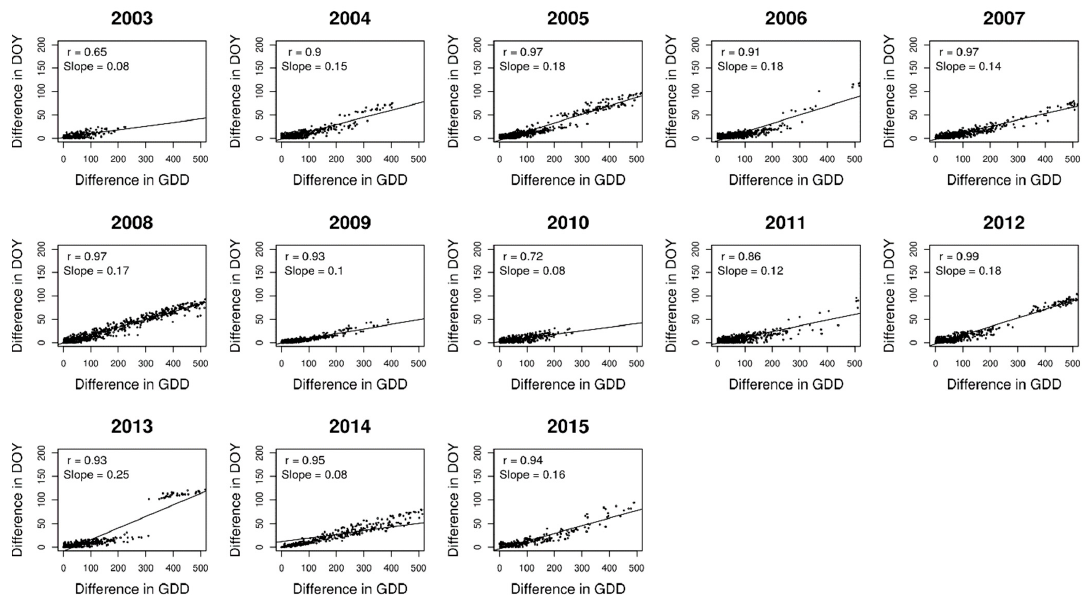
Figure A5. Linear regression fit between the difference in observed flowering DOY (number of days) and the difference in modelled GDD (number of degree days) for pairs of spatially connected observations of cow parsley flowering onset (see Figure A2). Correlation coefficient and rate of spatial change in DOY per unit of GDDs (i.e., slope of regression line) are given for each observation